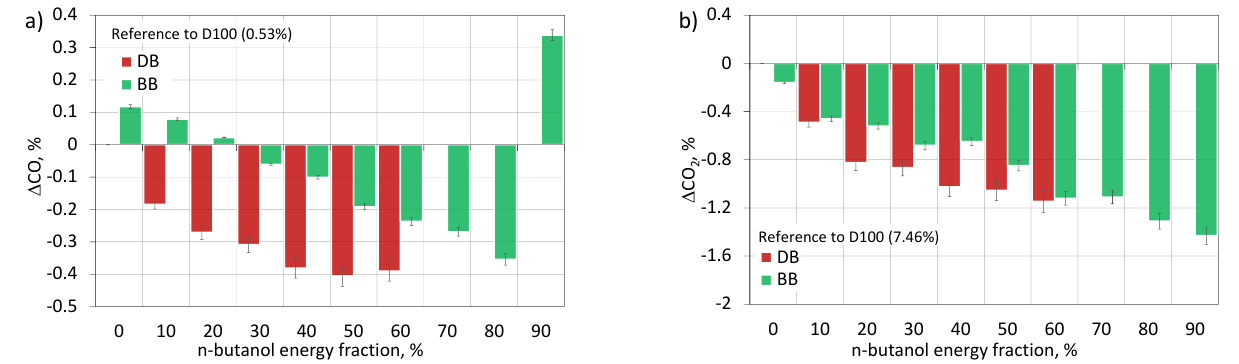
Figure 19. Emission of CO ( a ) and CO 2 ( b ) for test engine powered by diesel/n-butanol and RME biodiesel/n-butanol blends.